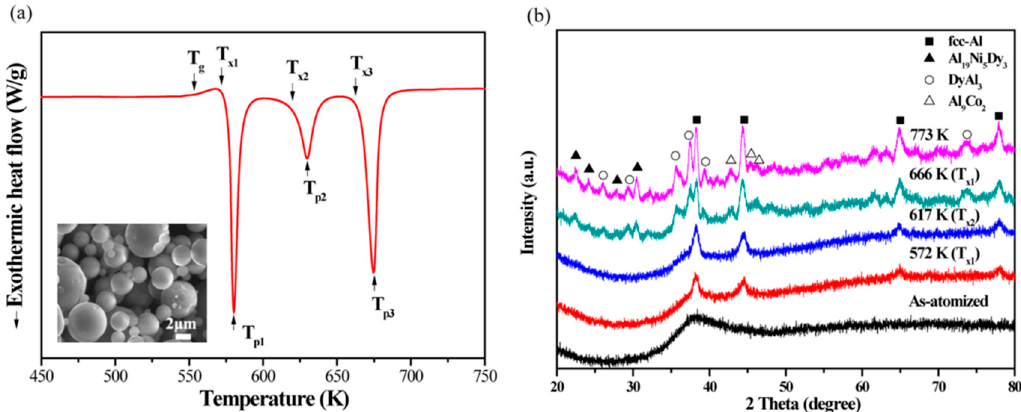
Figure 18. Thermal stability of amorphous Al84Ni7Co3Dy6 alloy in gas-atomized powder form: ( a ) DSC trace obtained during continuous heating of at a heating rate of 40 K/min with inset showing the powder morphology; ( b ) XRD patterns after heating to 299, 344, 393, and 500 °C. Both techniques show crystallization phenomena of marked phases [70].